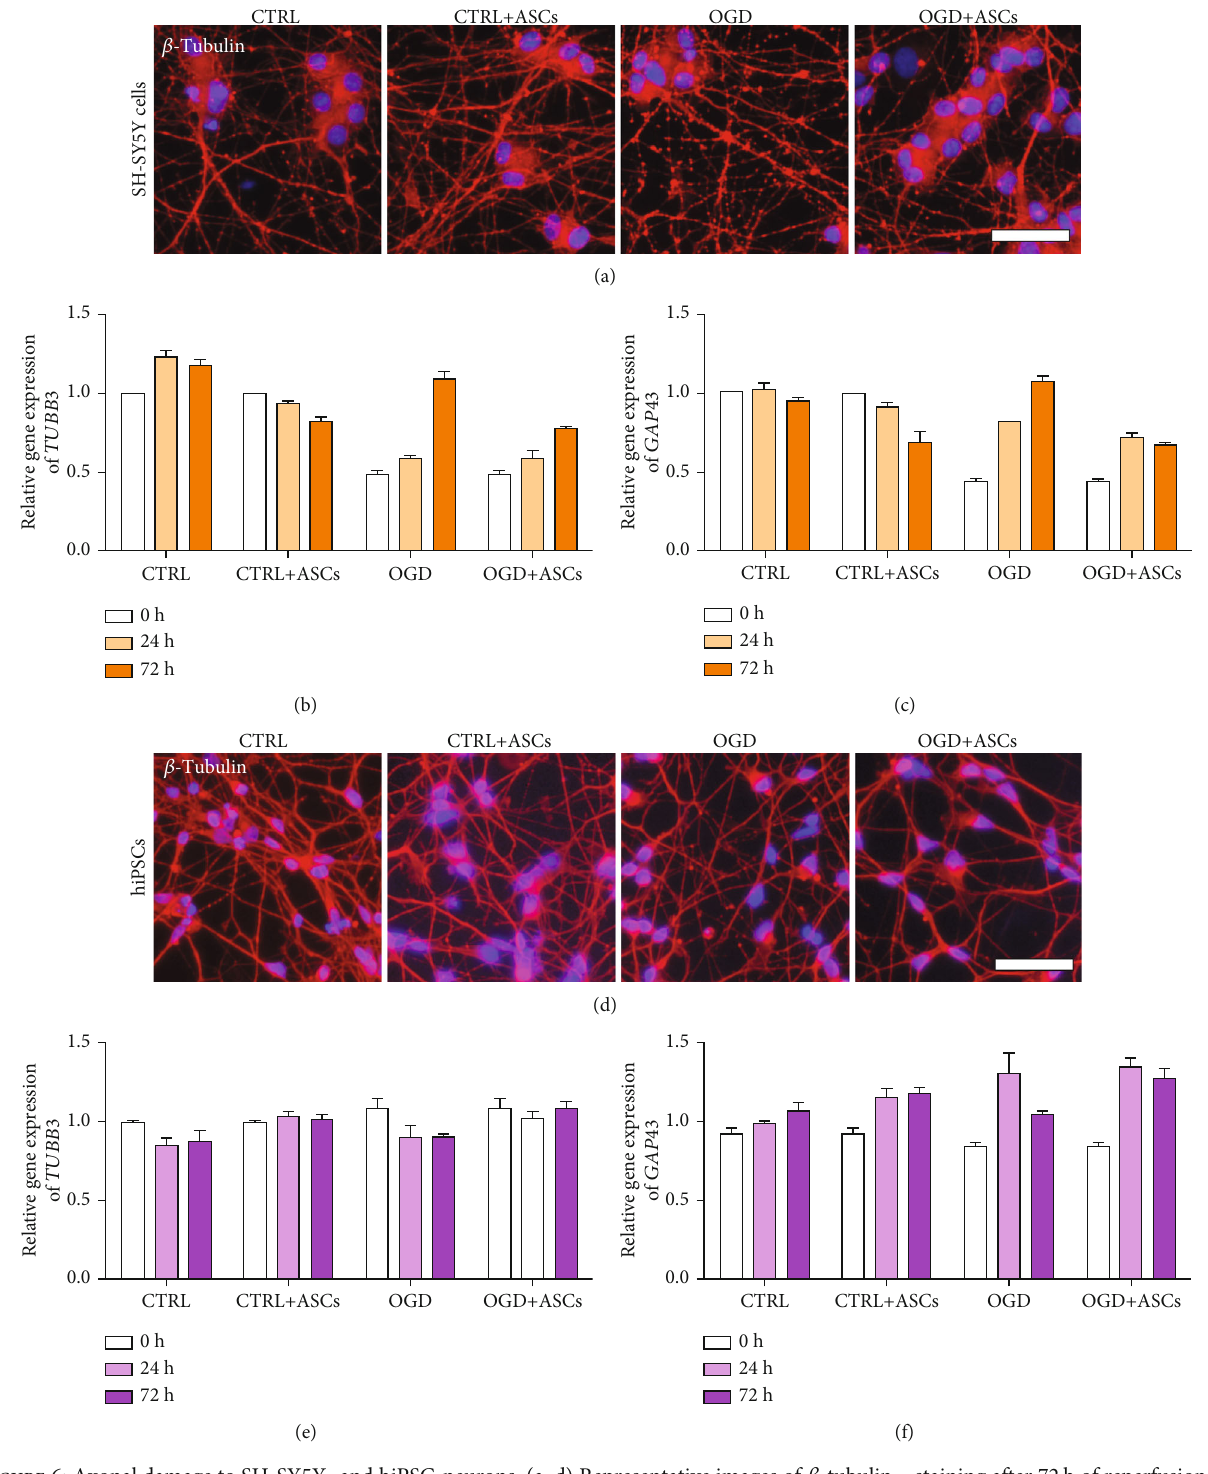
staining after 72 h of reperfusion in III ), scale bar, 50 μ m (representative images of two to four separate III